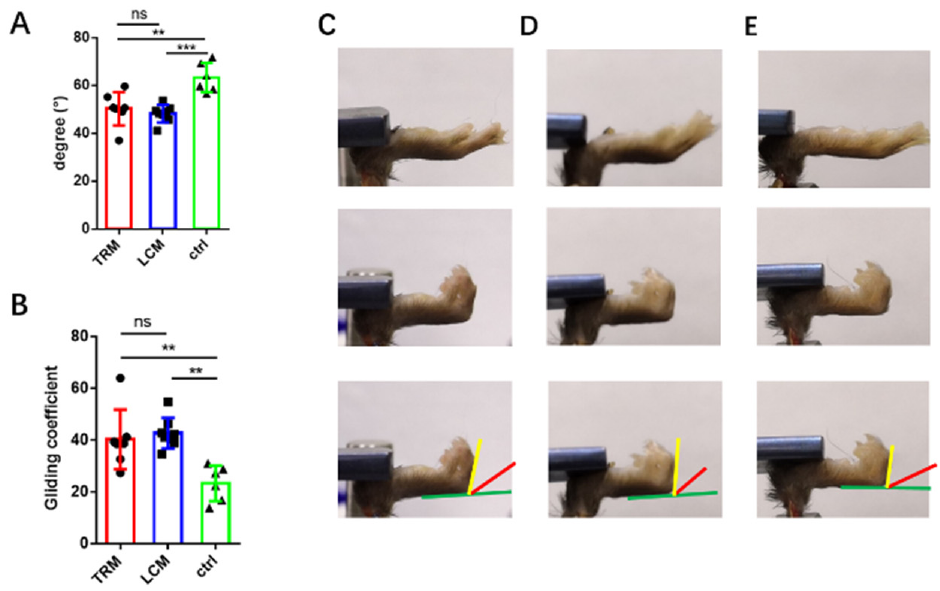
Figure 3. The range of motion in the three groups. ( A , B ) The range of motion (ROM) and gliding coefficient. ( C – E ) The Schematic diagram of measuring ROM. ( C – E ) The representative measure- ment of ROM in the LCM, TRM and control group, respectively. Two different loadings (0 g/19 g)